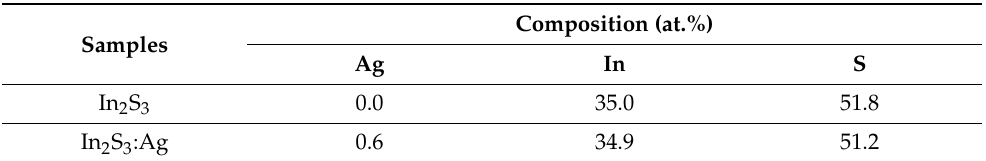
Table 1. Energy-dispersive X-ray spectroscopy (EDX) composition of the film surface of indium sulfide films. Composition (at.%) Samples Ag In S In 2 S 3 0.0 In 2 S 3